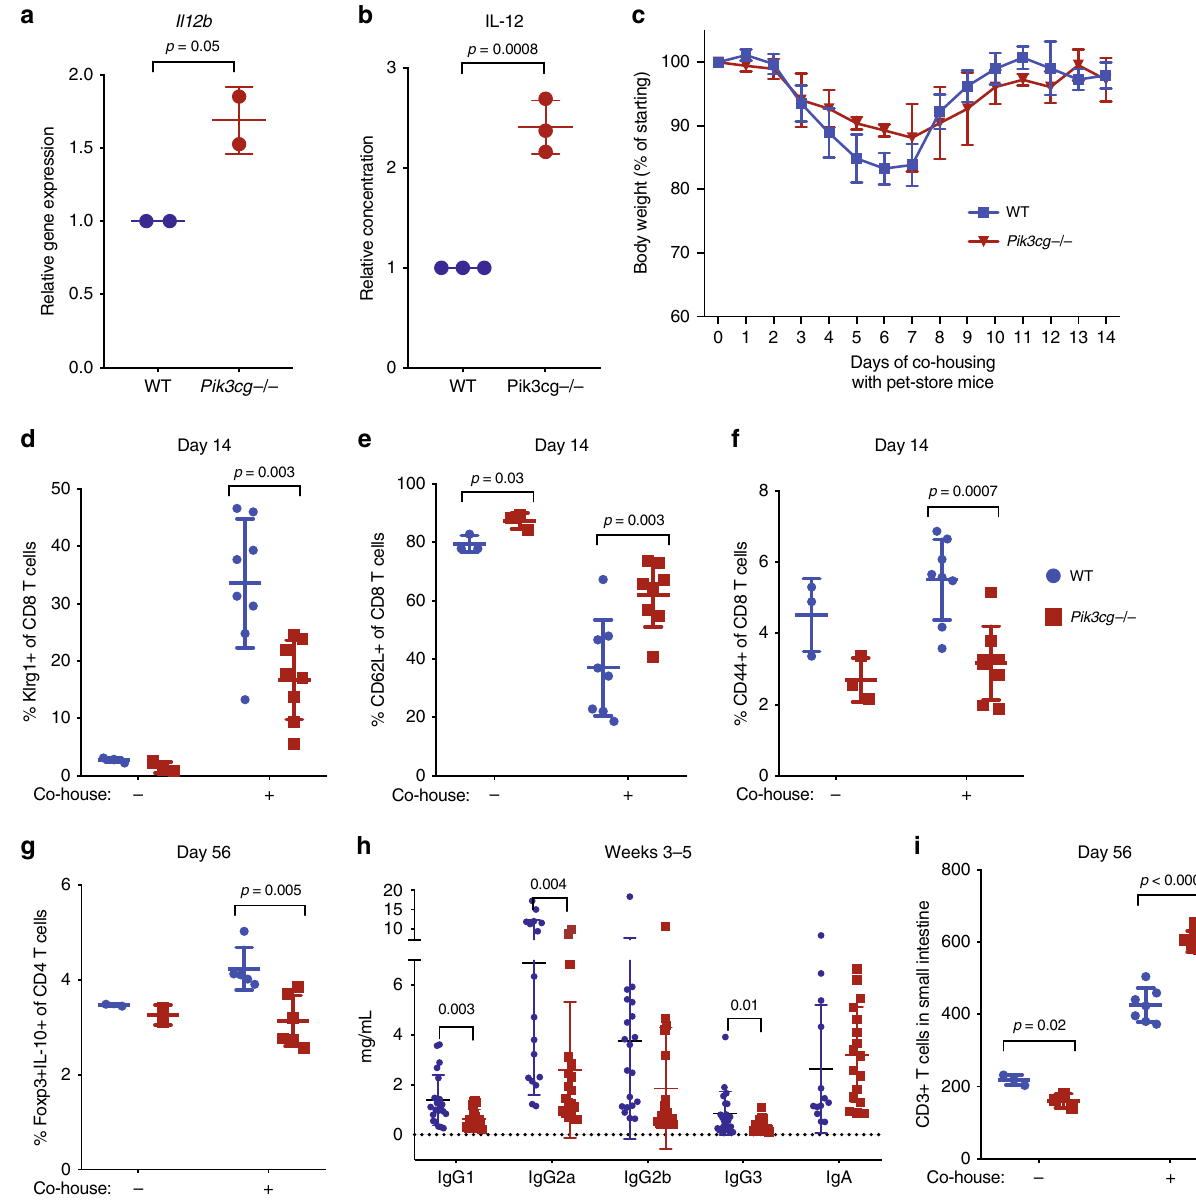
Fig. 4 Pik3cg -de fi cient mice recapitulate major features of human disease after exposure to natural microbiota through co-housing with pet-store mice. a mRNA expression of IL12b normalized to Hprt1 and Rpl13a in murine bone marrow-derived macrophages stimulated with LPS (100ng/mL) and IFN γ (5ng/mL) for 24 h. Data from two independent experiments (each with n = 2/group) are presented as mean ± SD. b Supernatant IL-12 concentration from murine bone marrow-derived macrophages stimulated with LPS (100 ng/mL) and IFN γ (5 or 20 ng/mL). Data are presented as mean ± SD and combined from three independent experiments. c Body weight of Pik3cg − / − and wild-type mice co-housed with pet-store mice. Data are representative of four independent experiments. d – f Frequency of Klrg1 + , CD62L + , and CD44 + among CD8 + T cells from animals with or without exposure to pet-store mice at day 14. Data are presented as mean ± SD and are representative of four independent experiments (n = 3 for each non-co-housed group and n = 8 for each co-housed group). g Frequency of IL-10 + Foxp3 + cells among CD4 + T cells after PMA/ionomycin stimulation of splenocytes from WT (n = 2 for non-co-housed and n = 5 for co-housed) and Pik3cg − / − (n = 2 for non-co-housed and n = 6 for co-housed) after 56 days. Data are presented as mean ± SD. h Concentration of antibodies in serum from animals at 3 – 5 weeks after exposure to pet-store mice. Data are presented as mean ± SD, summarized from four independent experiments (n = 17 – 21 for each group). Statistical analysis was performed using unpaired T-test validated with Holm-Sidak method. i Total number of CD3 + T cells by immunohistochemistry per 200 μ m section of small intestine from animals with or without exposure to pet-store mice at day 56. Data are presented as mean ± SD and representative of three independent experiments (n = 3 for non-co-housed and n = 7 for co-housed WT; n = 3 for non-co-housed and n = 6 for co-housed Pik3cg − / − ). Statistical analysis was performed using two-tailed unpaired T-test in a – g and